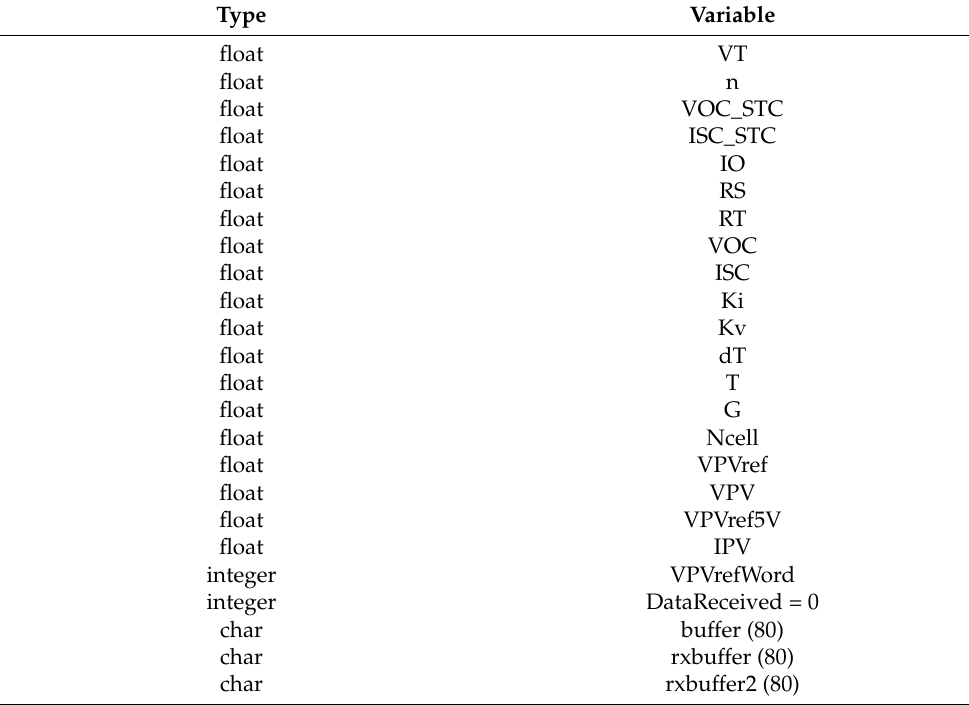
Table 6. Declaration Variables of the DSP